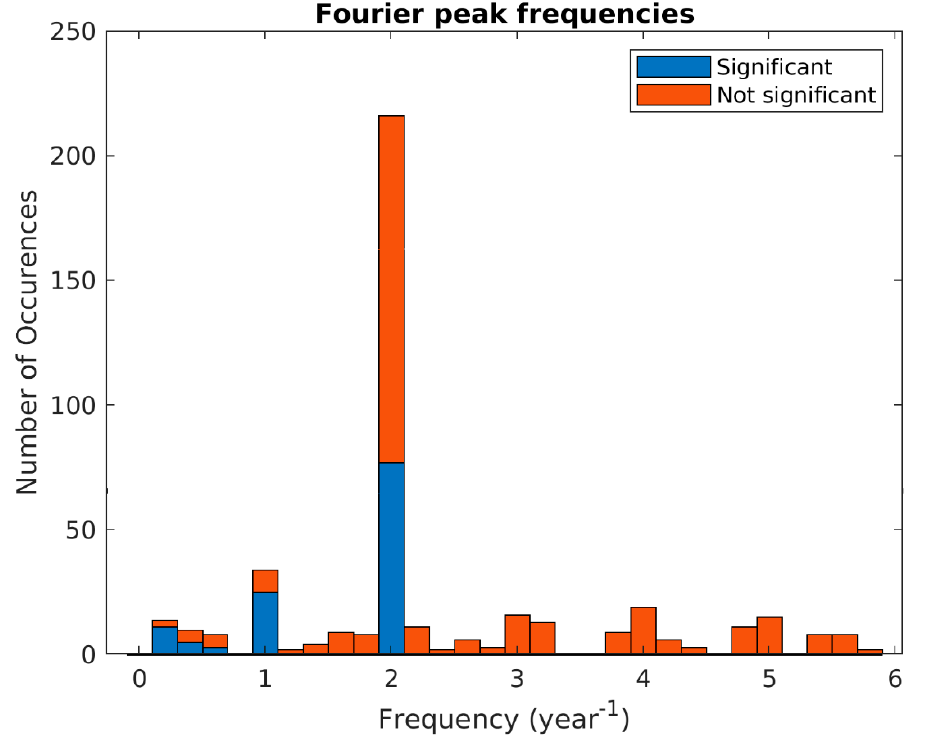
Figure 14. Histogram of the frequencies of the secondary peak in the Fourier amplitude spectrum for the Longreach range-azimuth cells. the Longreach range-azimuth